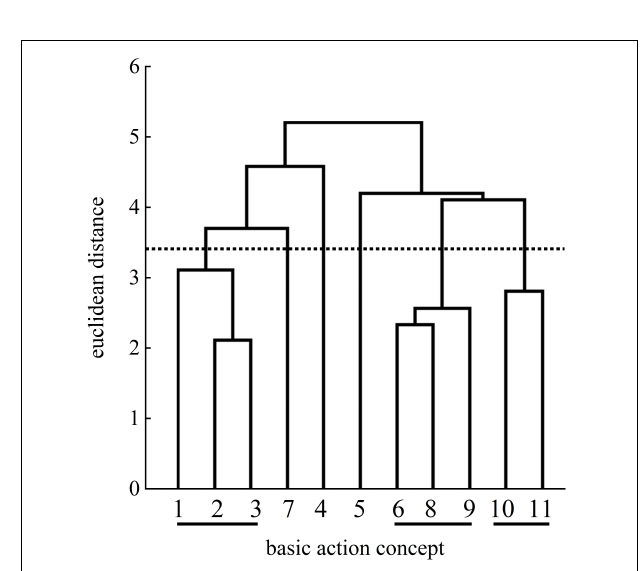
no functional units of the mental representation